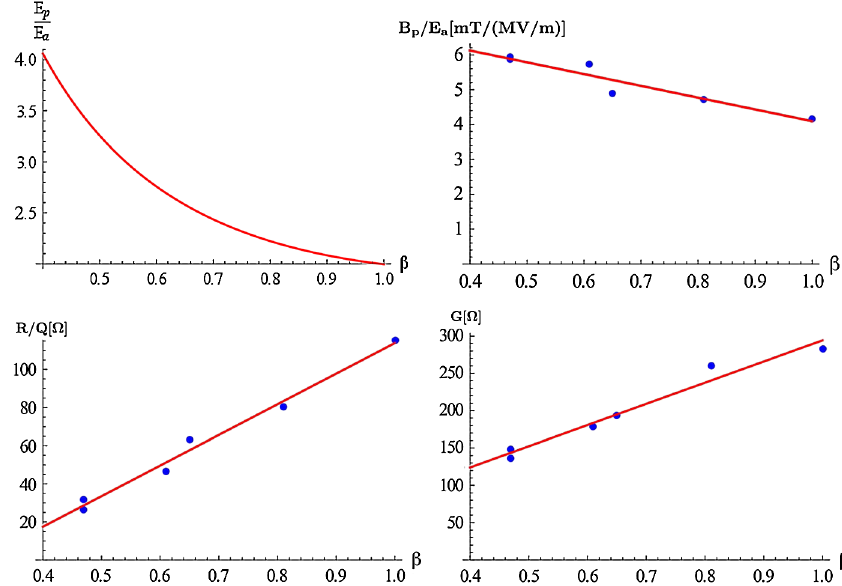
FIG. 5. (Color) Typical dependence of the surface electric field (upper left), the surface magnetic field (upper right), the R=Q value (lower left), and the geometry factor (lower right) on the phase velocity (cid:1) of a low- (cid:1) elliptically shaped accelerating structure, as collected in Table